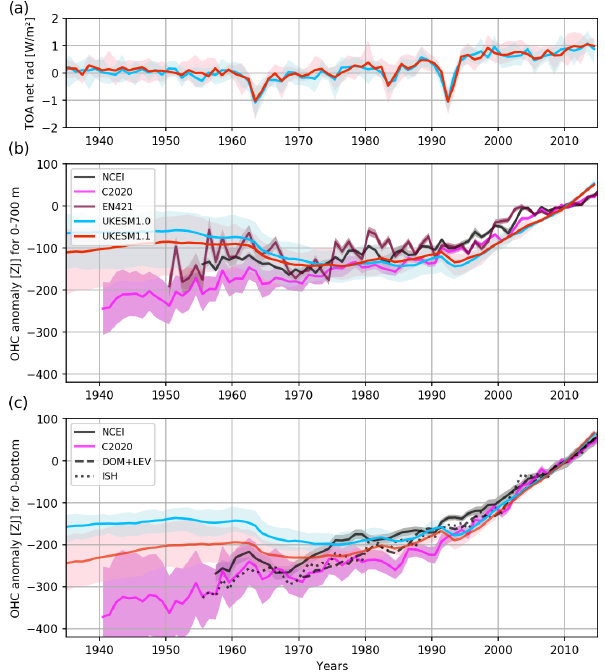
Figure 10. (a) TOA net radiation, (b) 0–700m global ocean heat content (OHC) anomaly and (c) full-depth global OHC anomaly for the UKESM1.1 (red) and UKESM1 (blue) historical simulations. Observation-based OHC time series (b, c) are plotted in black, pur- ple and maroon. TOA net radiation time series are anomalies with respect to the average of 1850–1870. OHC time series (simula- tions and observations) are anomalies with respect to the average of 2005–2014. Shading shows the range of the ensemble for simu- lations and the standard error for the observational